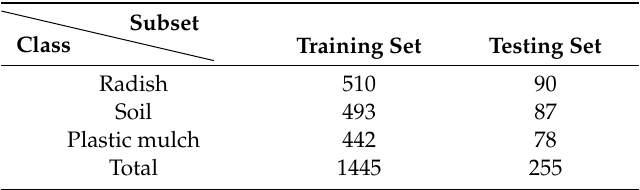
Table 3. The number of images for each class (radish, soil, and plastic mulch) of the training set and the testing